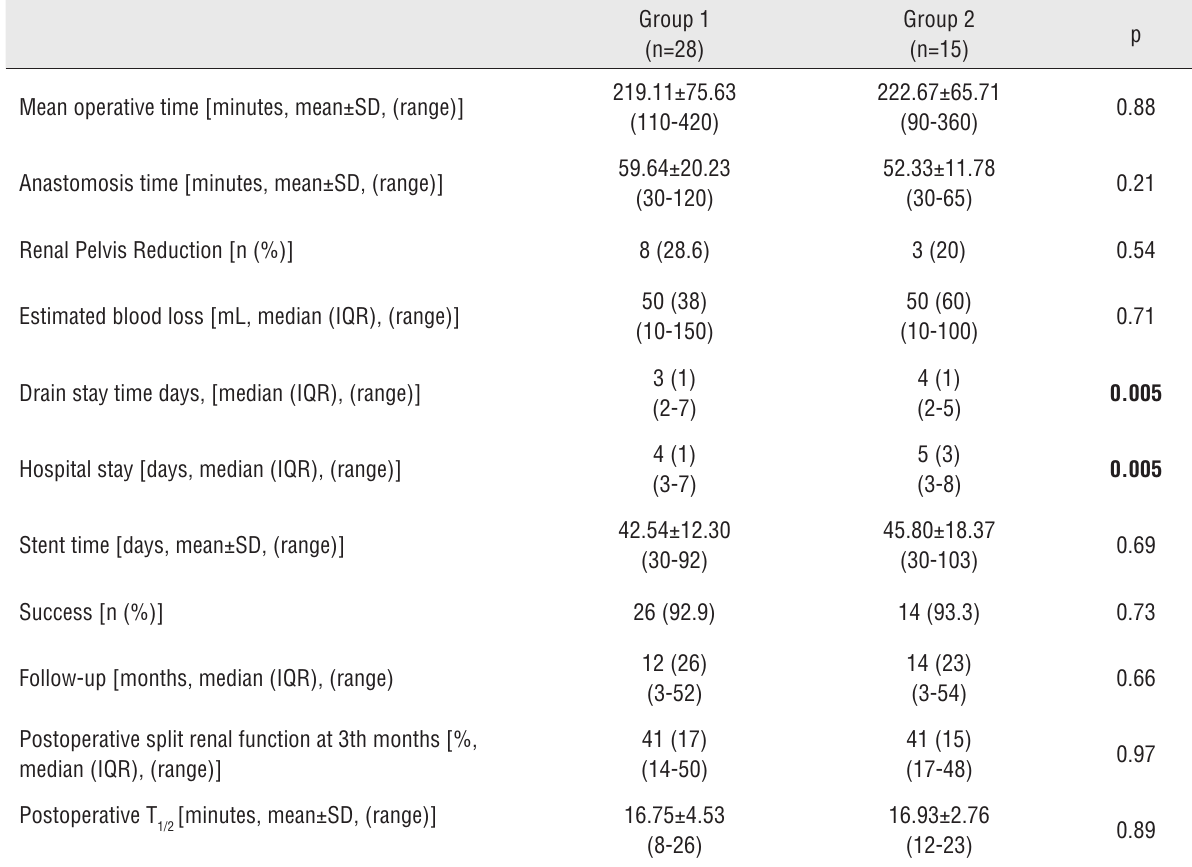
Table 2 - Operative characteristics of patients.